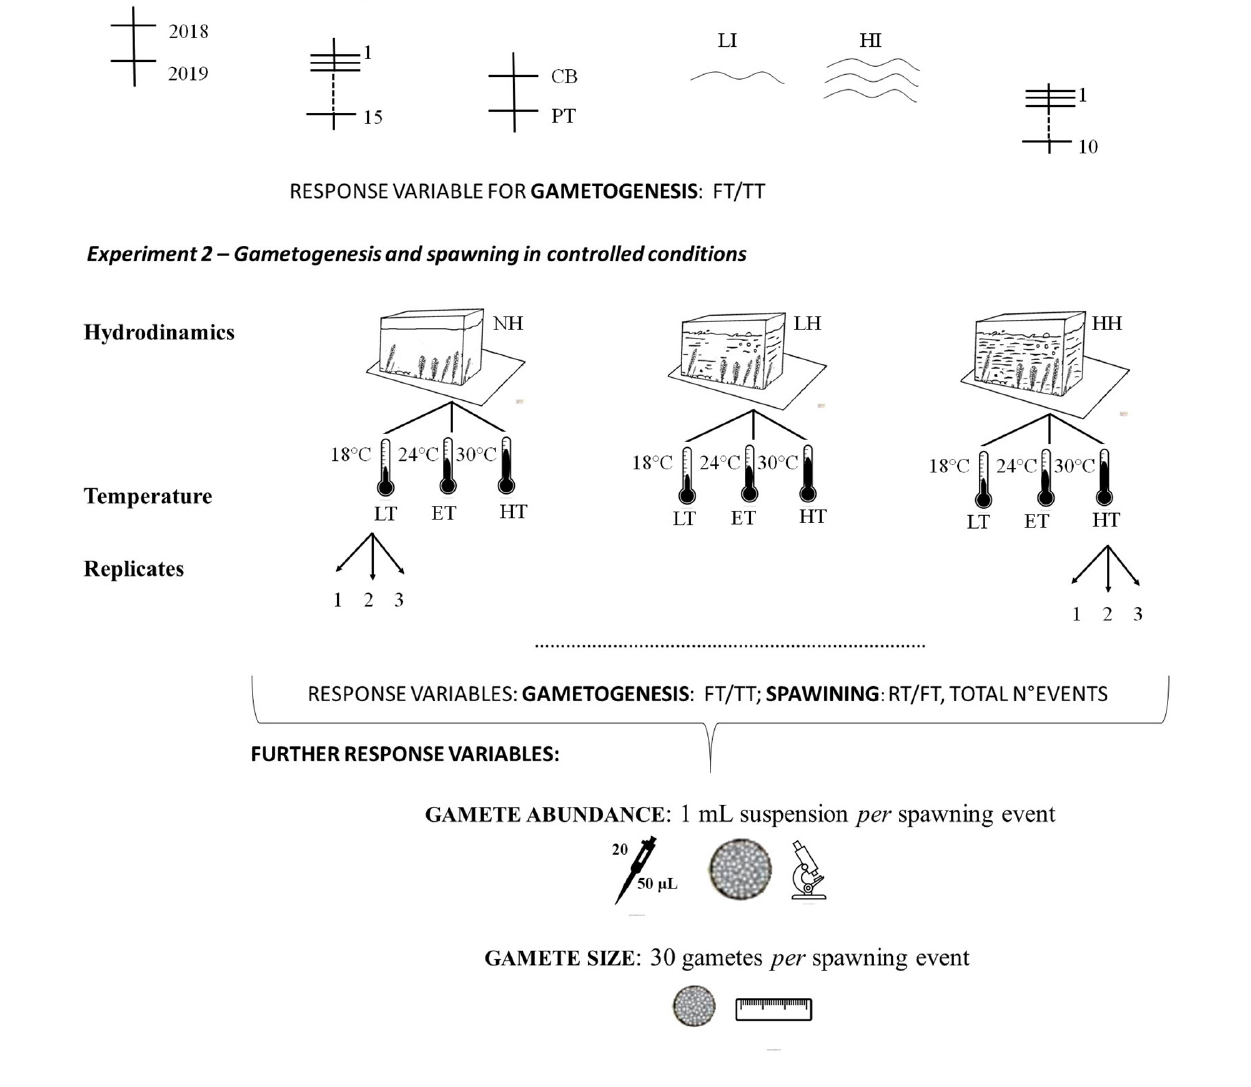
FIGURE 2 | Schematic representation of the sampling design for the two performed experiments. Sites: CB: Cala Bua; PT: Porto Taverna. Water motion: NH: no water motion; LH: low water motion; HH: high water motion. Temperatures: LT: lower temperature (18 ◦ C); ET: equal temperature (24 ◦ C); HG: higher temperature (30 ◦